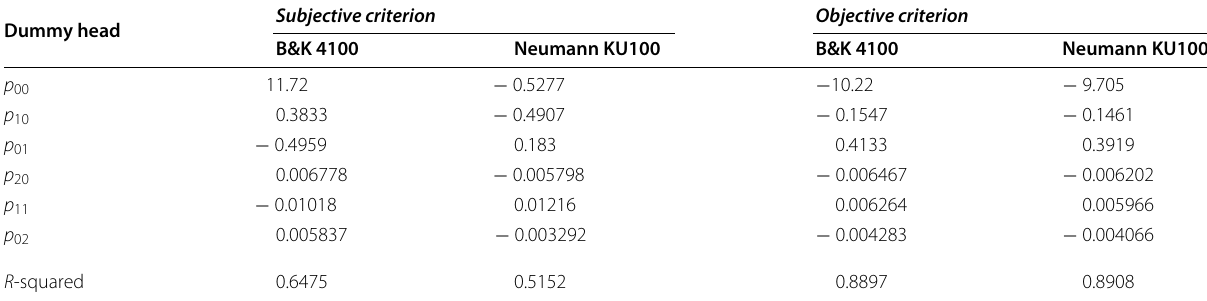
Table 6 Direct application (not normalized) coefficients of the polynomials, for the scaling of the ITD of the two dummy heads